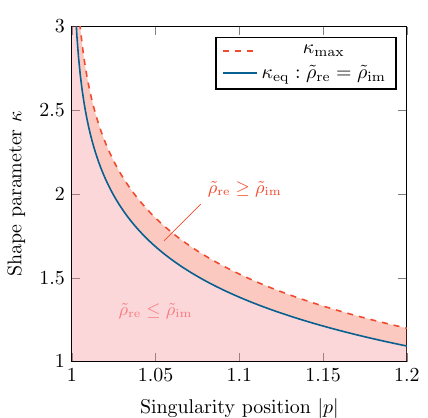
Figure 4. The Bernstein ellipse with size ρ = 1.6 (singularity located at p = ( a ) and the corresponding Bernstein ellipses E ˜ ρ ( c ) and κ = κ eq ( d ). The singularities are depicted with hollow dots.